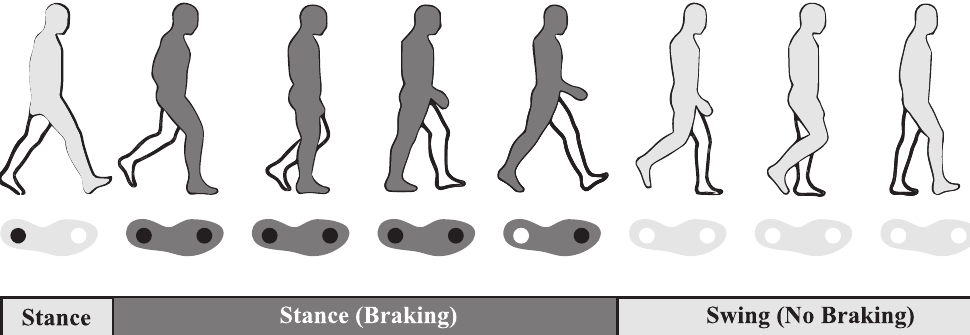
Figure 1. Brake actuation timing with respect to the gait cycle. The light gray color is the period during gait where the brake is not active and the leg is able to swing freely. The dark gray color is the period where the brake is active. The and symbols show the locations on the foot of no applied (cid:35) (cid:32) pressure and applied pressure during the corresponding gait